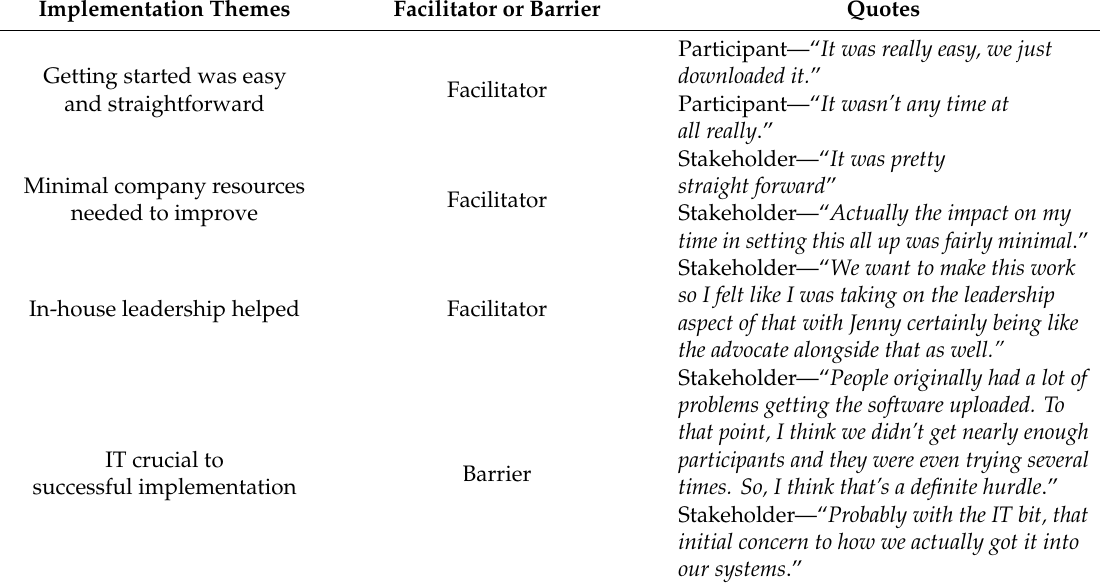
Table 8. Qualitative themes and relating to indicators of